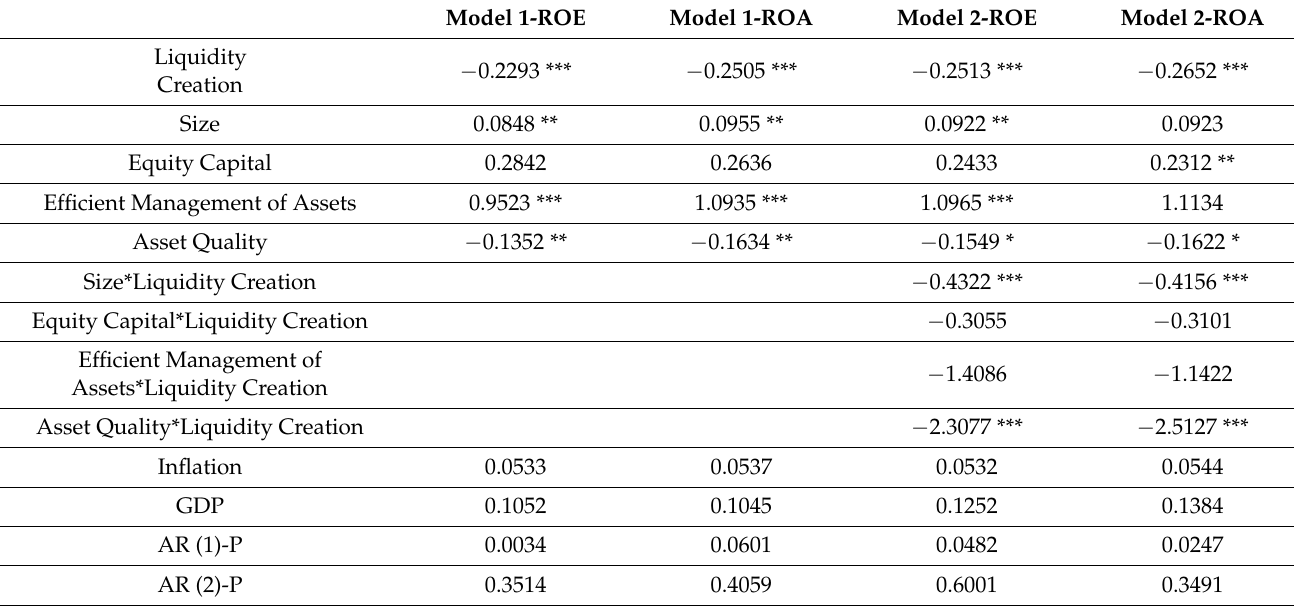
Table 3. Generalized method of moments model.